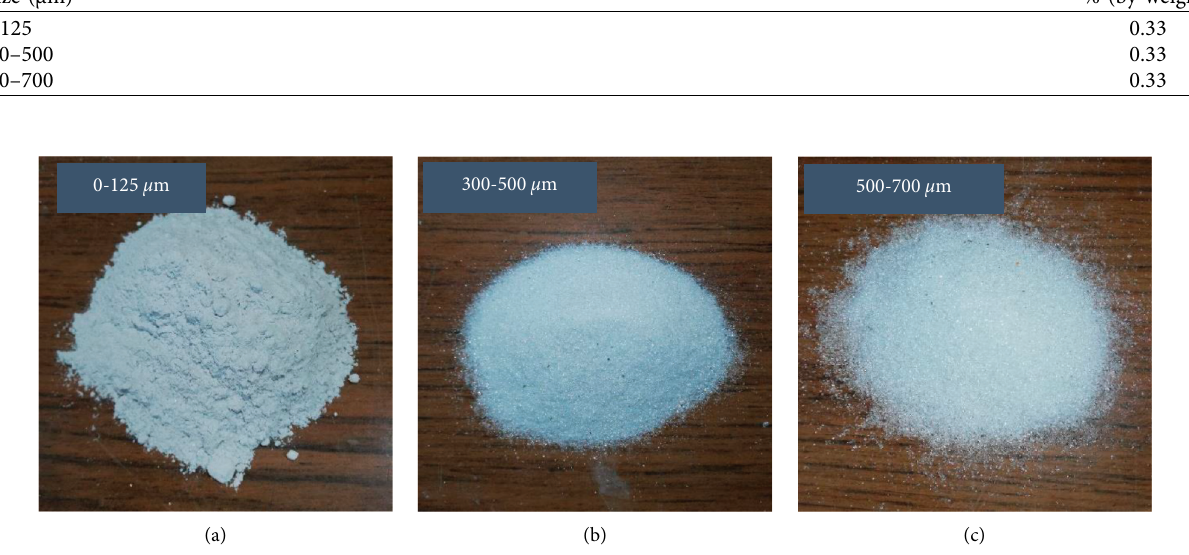
Figure 3: Waste glass powder: (a) 0–125 µ m, (b) 300–500 µ m, and (c) 500–700 µ m [46].